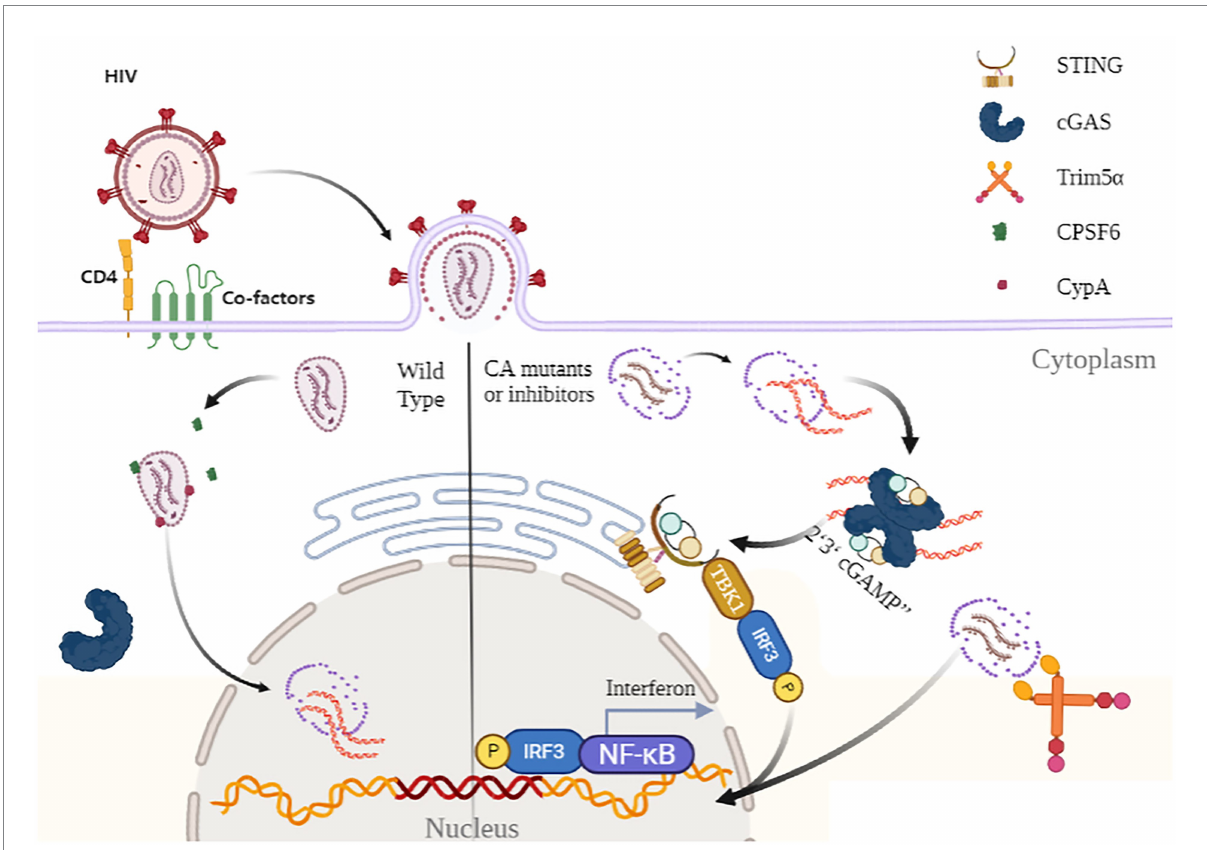
FIGURE 1 The schematic of HIV-1’s innate immune evasion in CA-dependent pathway. After the invasion, CA protects the HIV-1 virus after the invasion from innate immune recognition and ensures it translocates into the nucleus to complete its lifecycle. Alteration of CA formation and CA- interaction by genetic mutation or CA inhibitor could induce host cell IFN secretion through the cGAS-STING signal pathway. Disrupting CA interaction with CypA, CPSF6 will stimulate NF- κ B activity, and downstream IFN response leads to defects in HIV-1’s infectivity. Furthermore, CA-CypA interaction is essential for counteracting with Trim5 α to keep the CA core intact and inhibit Trim5 α -induced immune response through the NF- κ B signal